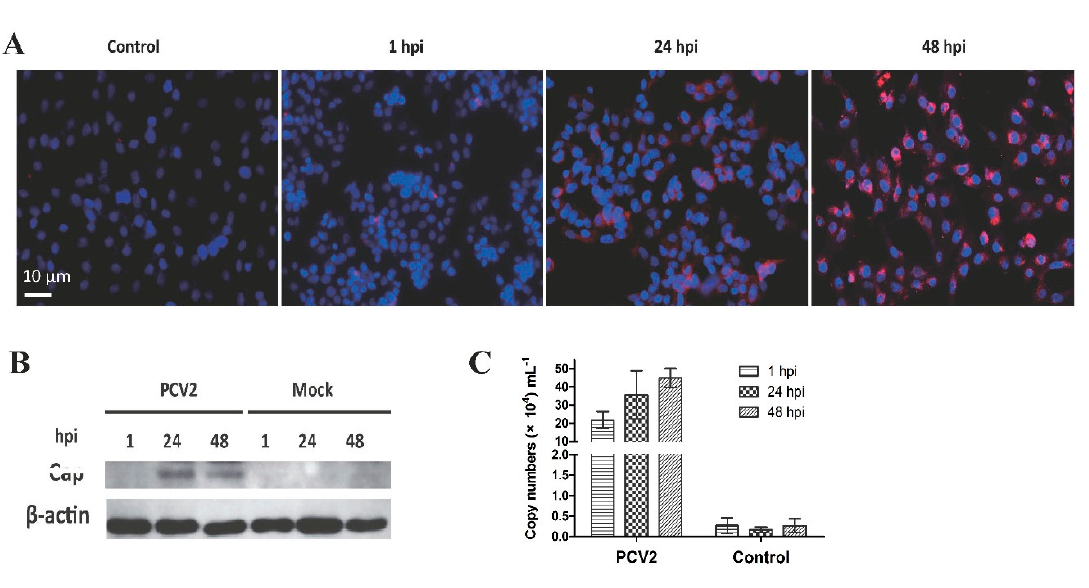
Figure 1. Porcine circovirus type 2 (PCV2) infection in porcine alveolar macrophages (PAMs). ( A ) PAMs were infected with PCV2b and processed for immunofluorescence assay at 1, 24, and 48 hpi. PCV2b was visualized by the ODs-psdAb probe against the Cap protein (red), the nucleus was stained with DAPI (blue). ( B ) Cap protein in PCV2b-infected PAMs was also detected by Western blot assay based on Cap protein (VLPs) immunized porcine serum. ( C ) PCV2 copy numbers were analyzed by qPCR at the time-points indicated. Results are mean ± SE of three independent experiments.